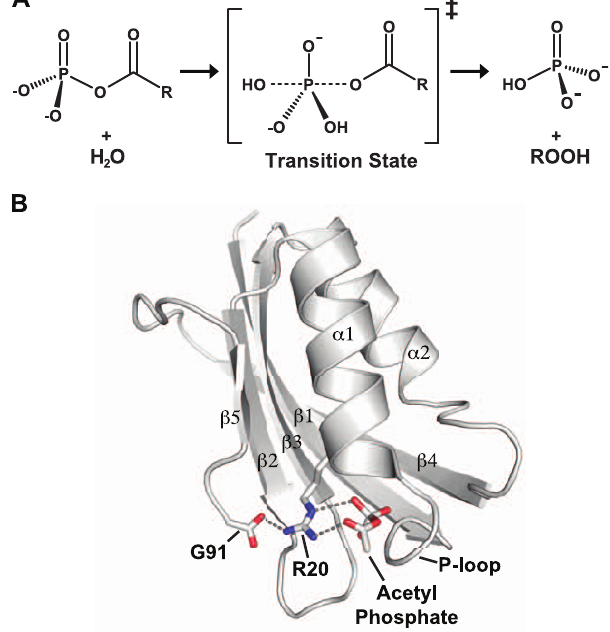
Figure 1. Acylphosphatases use an invariant arginine residue to catalyze the hydrolysis of its substrates. (A) The transition state of the enzyme-catalyzed hydrolysis of acylphosphate. (B) Schematic representation of the thermophilic PhAcP. The substrate acylphosphate was modeled to the active-site cradle, P-loop, by docking and molecular modeling [14]. The role of the active-site arginine residue (Arg-20) is to stabilize the negative charges in the transition state. In the structures of all thermophilic acylphosphatases determined to date, the active-site arginine residue forms a salt-bridge with the C-terminal carboxyl group.